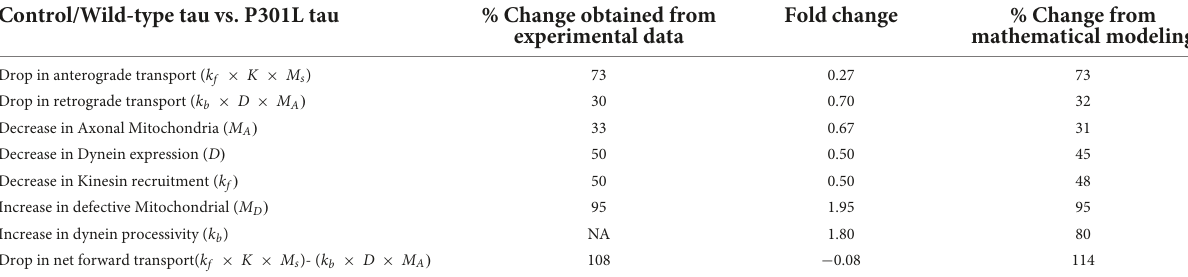
TABLE 1 Significant differences observed in tauopathy neurons with respect to controls and the mathematical model validation. Control/Wild-type tau vs. P301L tau % Change obtained from experimental data